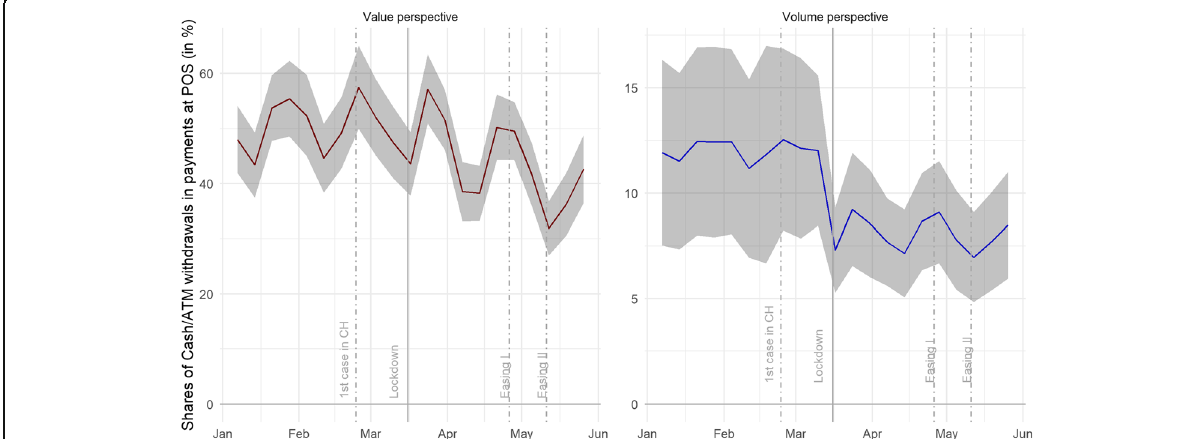
Fig. 4 Cash withdrawals relative to payments at POS (domestic card-present retail payments and cash withdrawals), as measured by weekly activities in terms of value (lhs) and volume (rhs) in 2020. Source: Own calculations, SIX BBS AG,